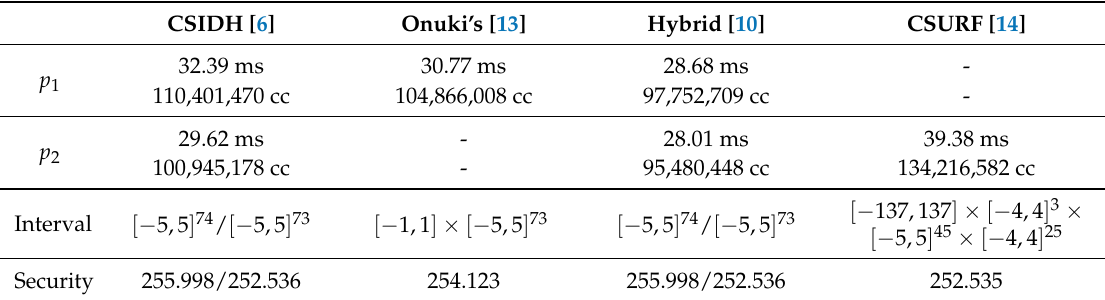
Table 4. Wall-clock time and clock cycles of group action of CSIDH-based algorithms